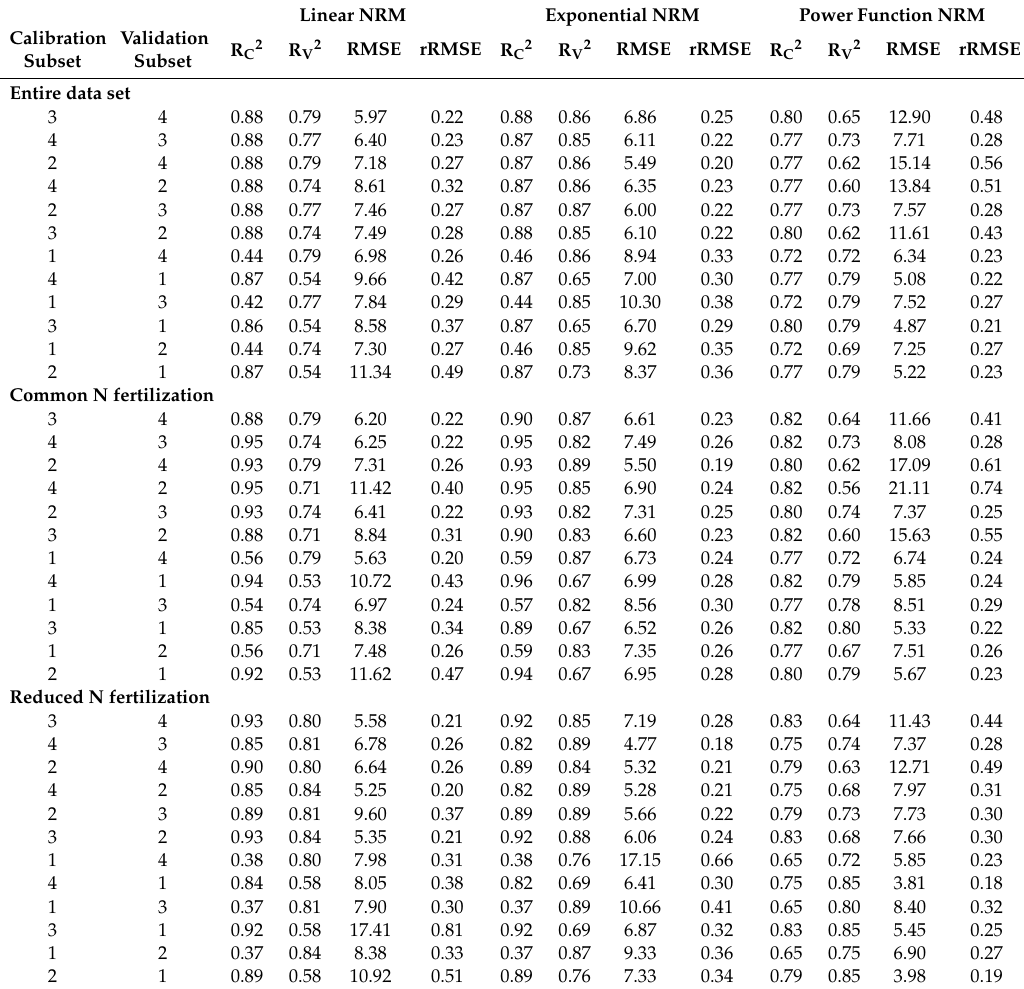
Table A2. Statistics for each run of the nitrogen regression models (NRMs) based on two-step model. (Calibration: R C2 : coe ffi cient of determination; Validation: R V2 : coe ffi cient of determination, RMSE: root mean square error (g / kg), rRMSE: relative root mean square error).